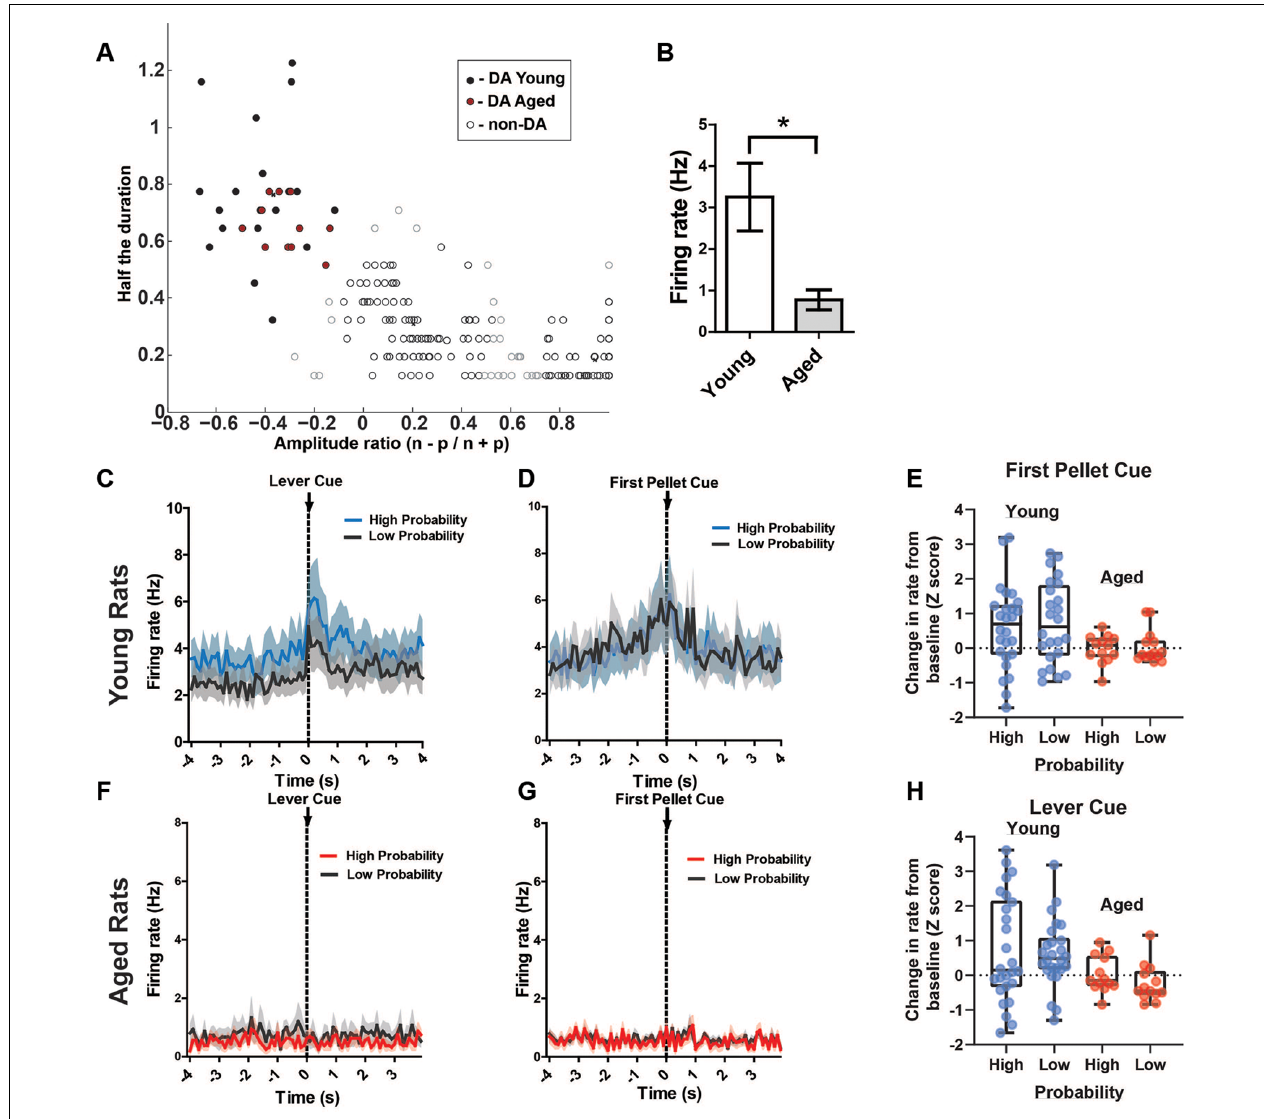
FIGURE 5 | (A) Results of cluster analysis for all ventral tegmental area (VTA) neurons ( N = 269). Putative dopamine (DA) cells were identified based on half spike duration and the amplitude ratio of the initial negative valley ( n ) and positive peak ( p ). Closed circles are putative DA neurons ( n = 38); open circles are classified as non-DA neurons ( n = 231). (B) The overall rate of the putative aged DA neurons (0.77 ± 0.24 spikes/s) was significantly reduced compared to young rats (3.25 ± 0.82 spikes/s; t (35) = 2.24, p = 0.02). (C) Mean firing rate (Hz) of young rats’ putative DA neurons ( n = 26) centered around the lever cue ( ± 4.0 s). Blue traces indicate responses during the 80% block; gray traces represent the 20% block. DA neurons’ responses to the lever cue was significantly greater than baseline firing rates (repeated measures ANOVA, significant main effect of time, F (2,25) = 10.92, p < 0.001) and this response was greater during the high probability block (Bonferroni post hoc multiple comparisons test, t = 2.32, p = 0.01). (D) Mean firing rate (Hz) of young rats’ putative DA neurons centered around the first pellet cue ( ± 4.0 s). The neurons significantly increased firing rate to the pellet cue compared to baseline (repeated measures ANOVA, significant main effect of time, F (2,25) = 10.49, p = 0.01), but they did not show significantly increased firing rates to this cue during the 80% block compared to the 20% block (Bonferroni post hoc multiple comparisons tests, t = 0.77, p > 0.05). (F) Mean rate (Hz) of aged rats’ putative DA neurons ( n = 11) centered around the lever cue ( ± 4.0 s). Red traces indicate responses during the 80% block; gray traces represent the 20% block. (G) Mean rate (Hz) of aged rats’ putative DA neurons centered around the first pellet cue ( ± 4.0 s). (E) Individual DA neurons’ normalized firing rate change from baseline to the first pellet cue ( Z scores). (H) Individual DA neurons’ normalized firing rate change from baseline to the lever cue ( Z scores). Blue dots represent young rats’ neurons; red dots represent aged rats’ neurons. These changes in firing rate are separated by the high and low probability blocks. * p < 0.05.